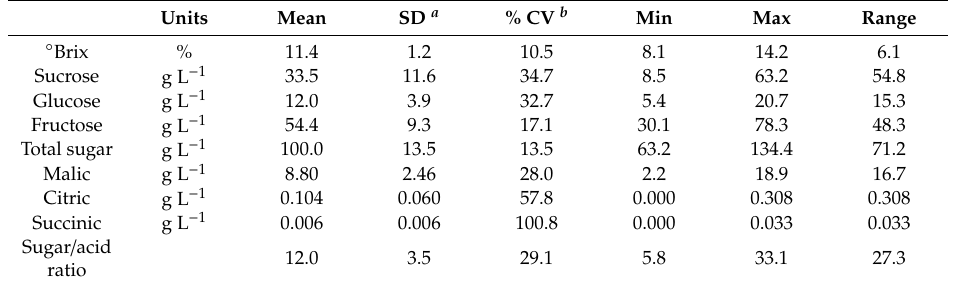
Table 2. Average concentrations of sugars and acids in the 86 apple juices, determined by ion chromatography.